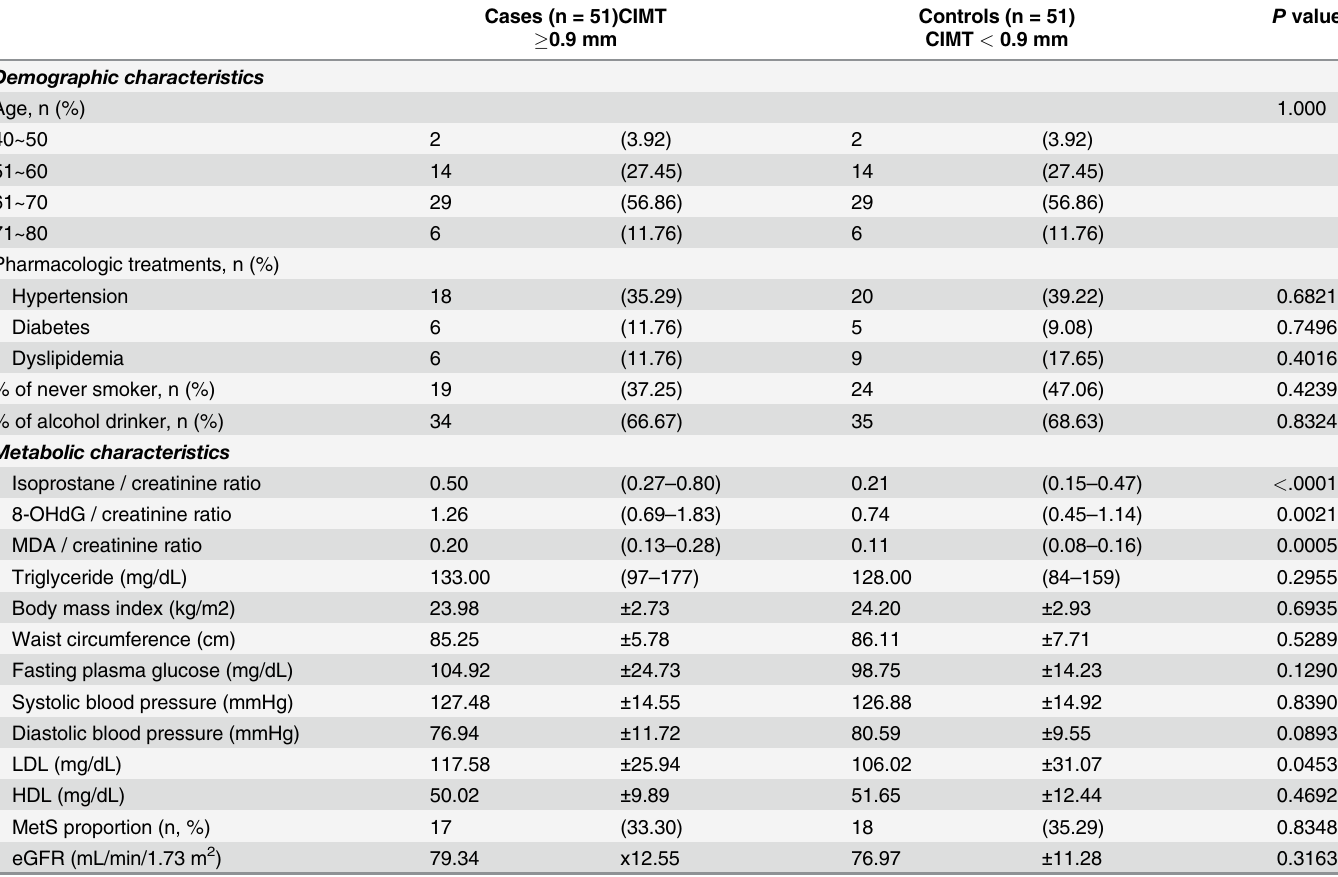
Table 1. Demographic and metabolic characteristics of the case and control